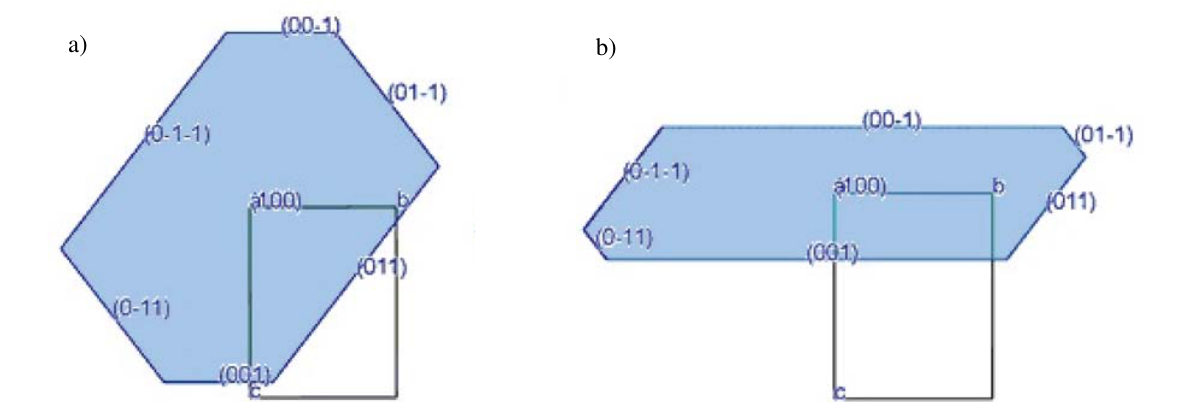
Figure 2: Crystal faces of crystals isolated from hydrophilic (a) and hydrophobic (b) solvent mixture. All crystals are projected along the a axis